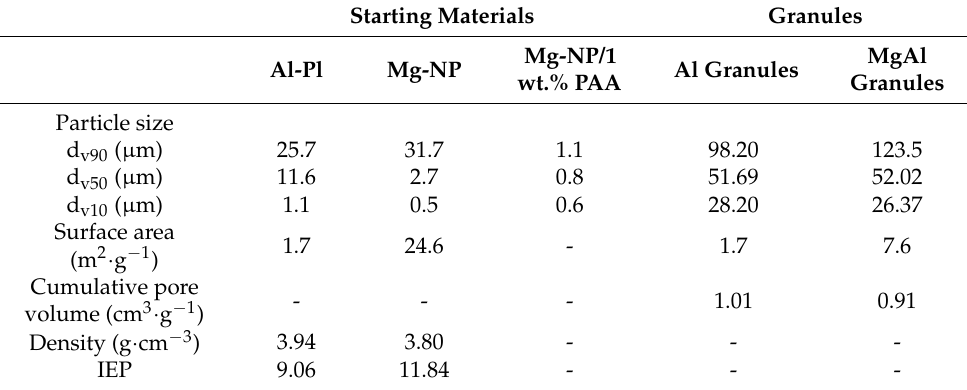
Table 2. Particle size distribution (d v90 , d v50 , and d v10 ), surface area, density, and IEP of starting powders and synthesized